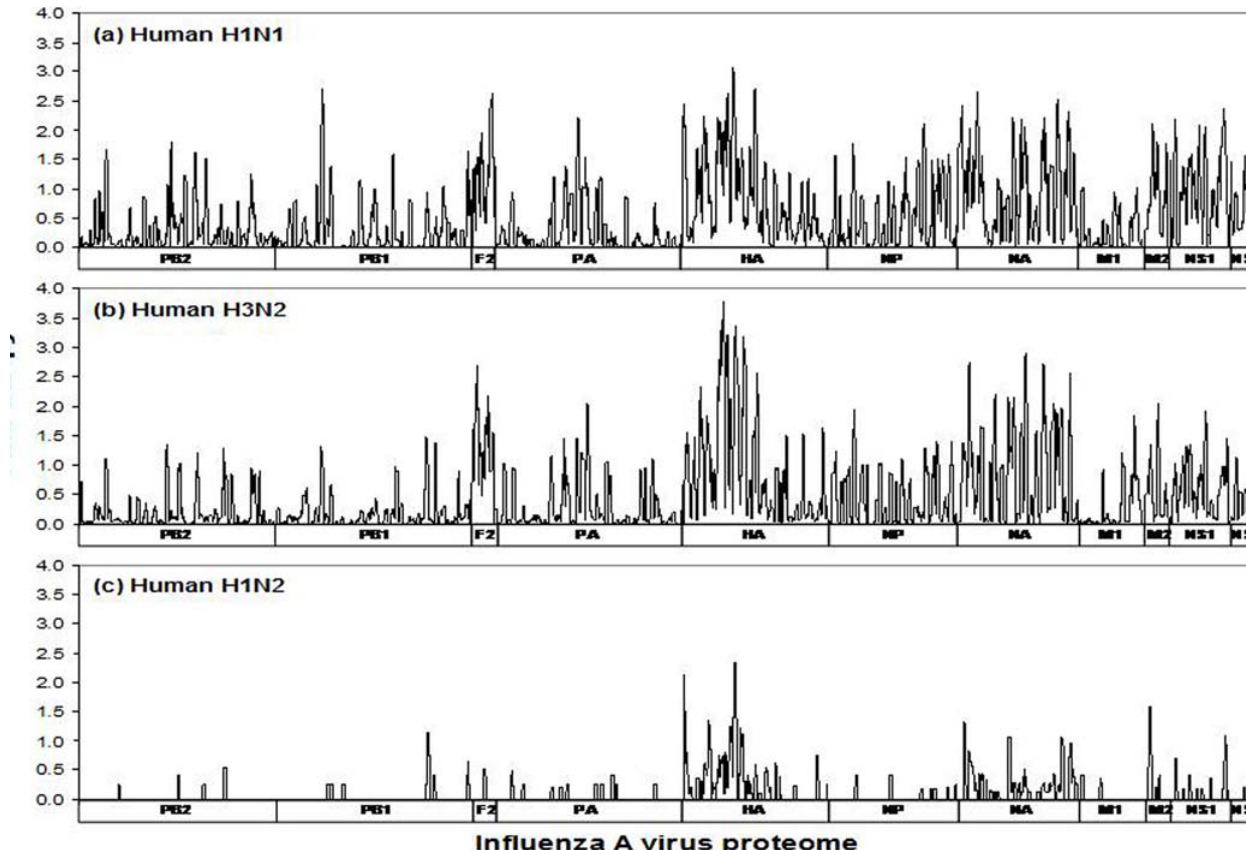
Figure 4. Entropy plots of recorded human influenza A subtypes H1N1, H3N2, and H1N2 from 1918–2006 (data as of September 30, 2006). doi:10.1371/journal.pone.0001190.g004 (Table S2). For example over 500 HLA class I and over 100 class